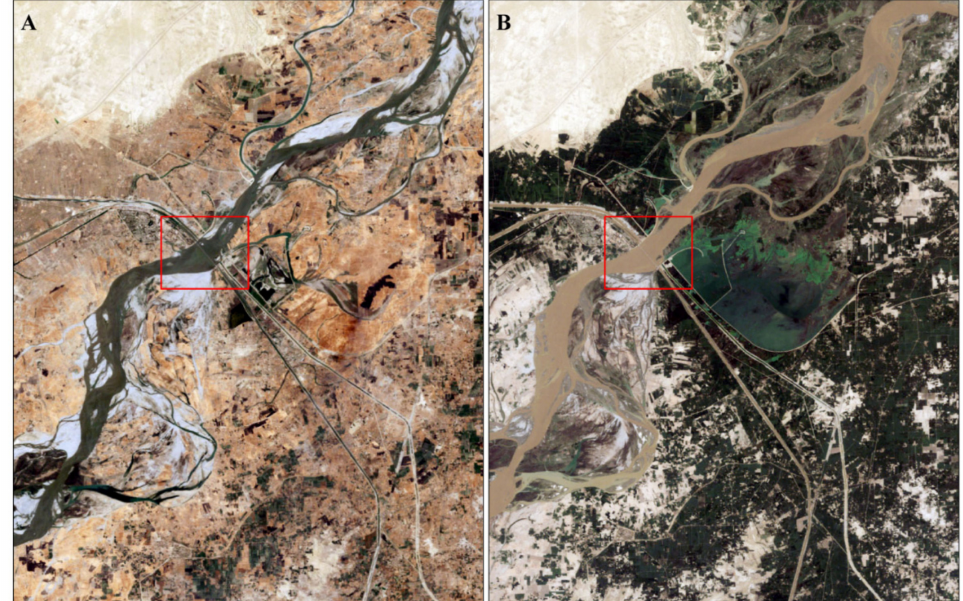
Figure 3. Satellite images from the Indus River near the Punjab and Sindh territories in opposite seasons: ( A ) typical shrinkage of the river discharge from May to November, when water is diverted for irrigation; ( B ) the swelling of the river from November to May due to high flow intensity (open access source from NASA Earth